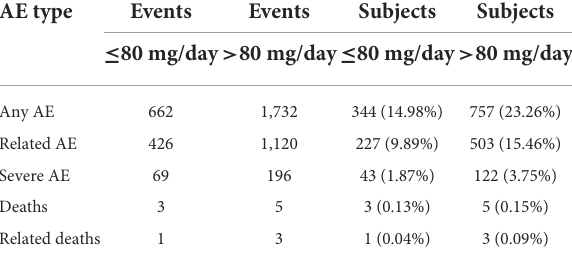
TABLE 6A Adverse events by posology groups.